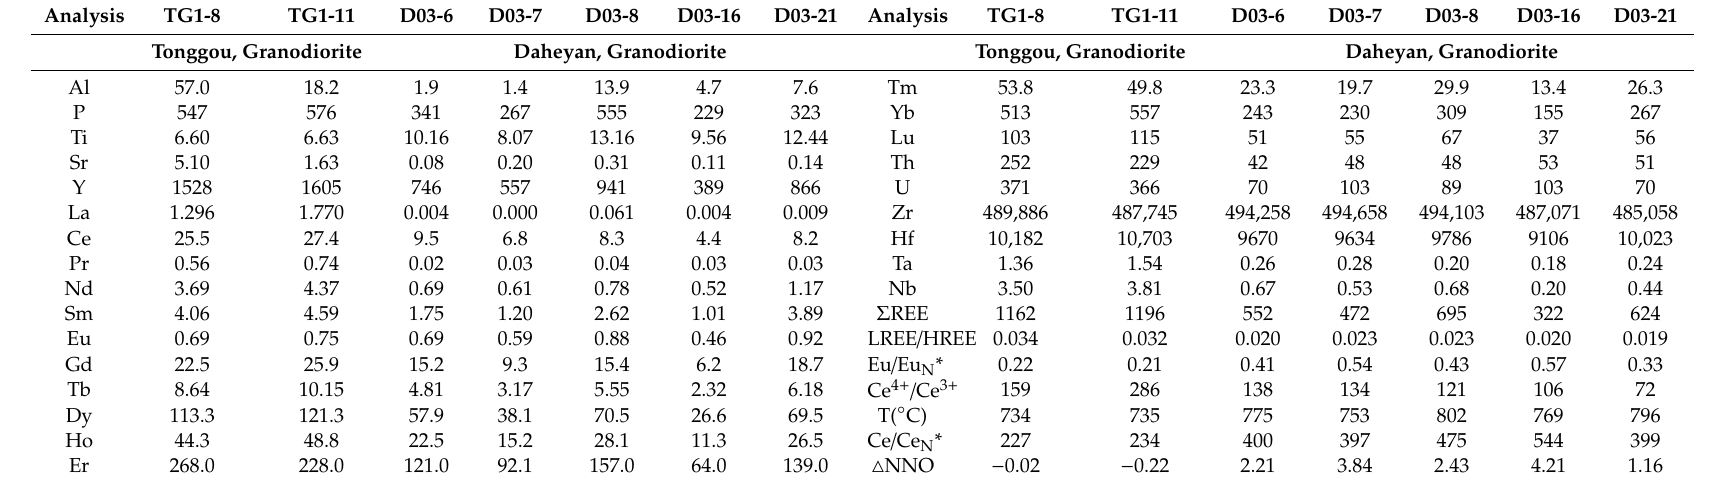
Table 4. Trace Element Abundance (in ppm), Ce 4 + / Ce 3 + and Eu Anomalies in Zircon, and Ti-in-Zircon